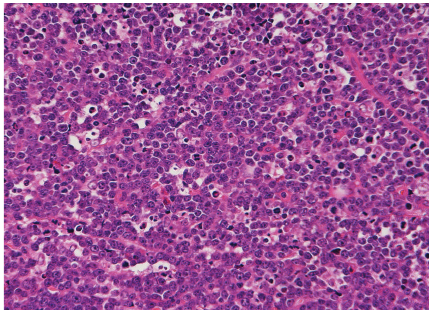
Figure 1: Histology from open wedge biopsy. The tumour showed diffuse sheets of lymphoid cells punctuated by tingible body macrophages (H&E 10X).